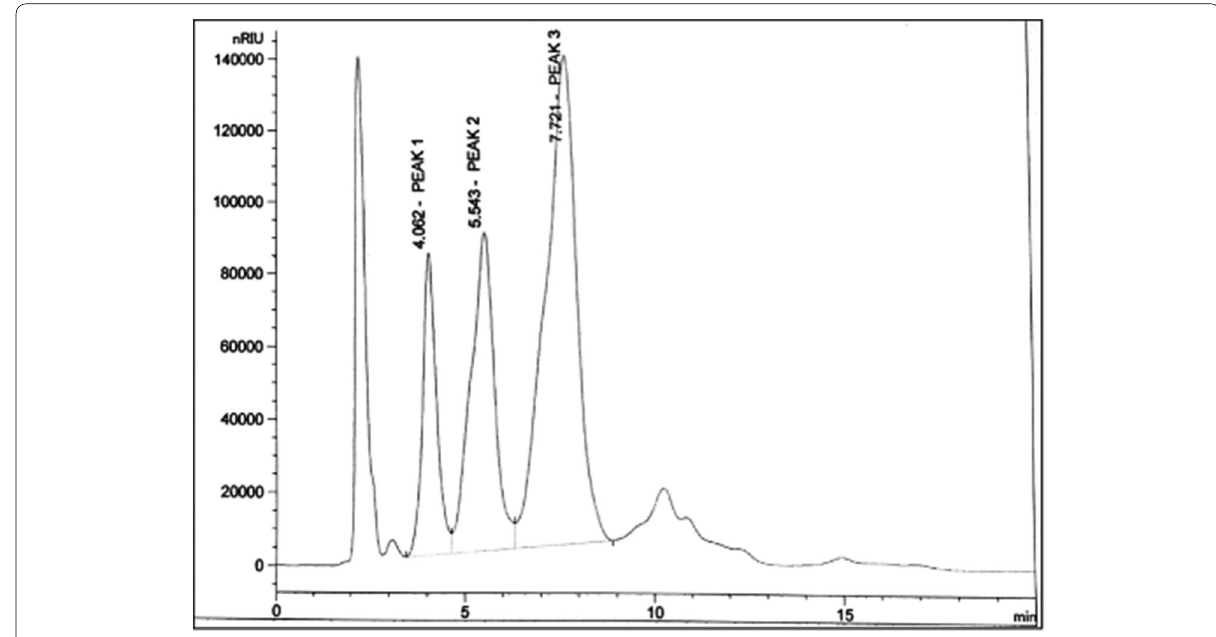
CFU/g of sample) of GOS 10